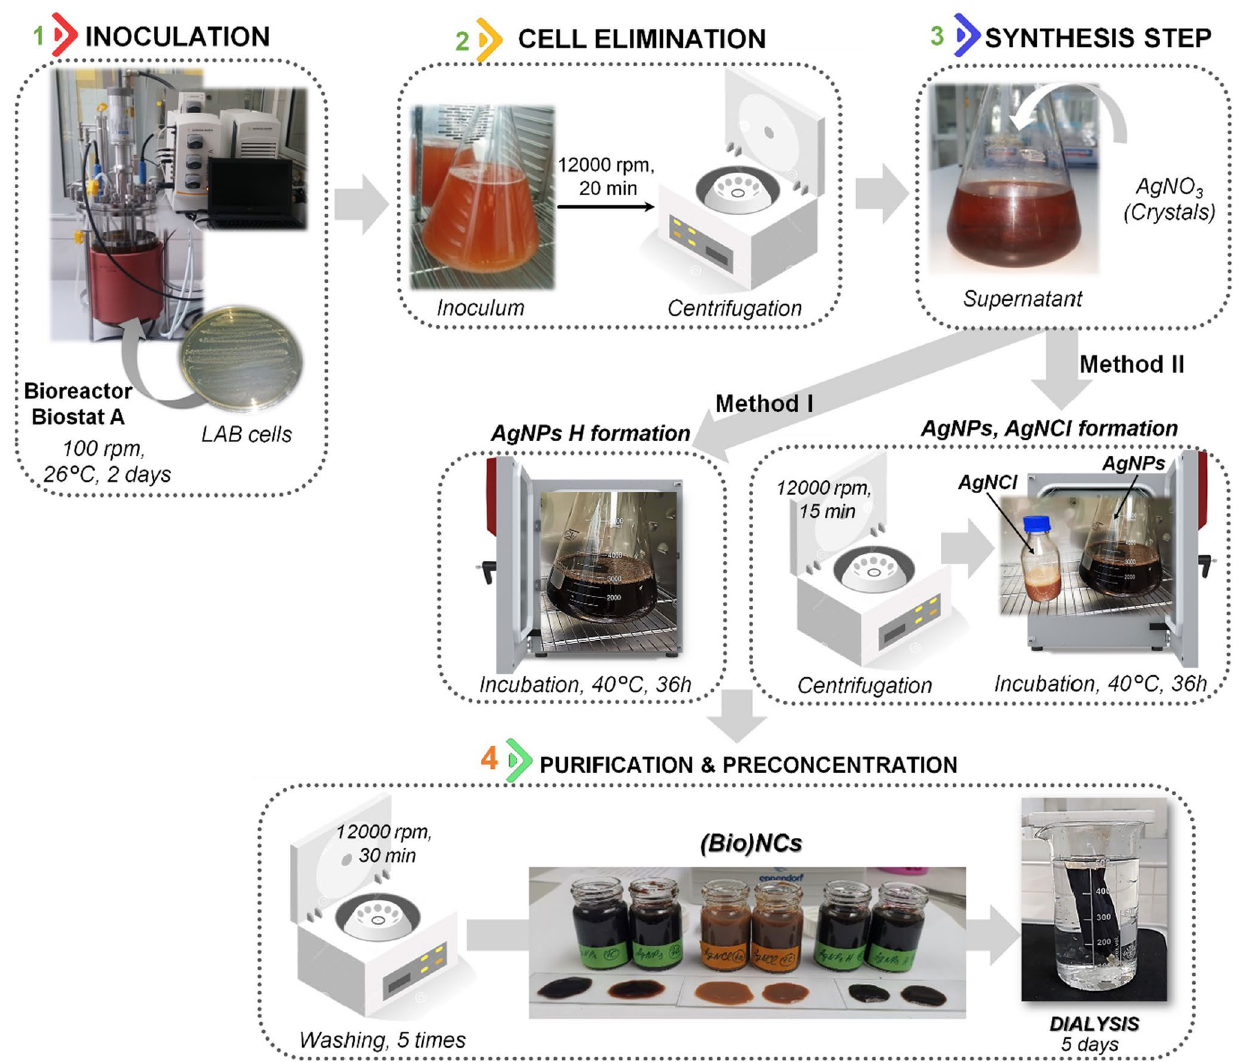
Fig. 1 Schematic illustration showing the involved steps for the (Bio)NCs types mediations including both “direct method” (Method I) as well as “modified method” (Method